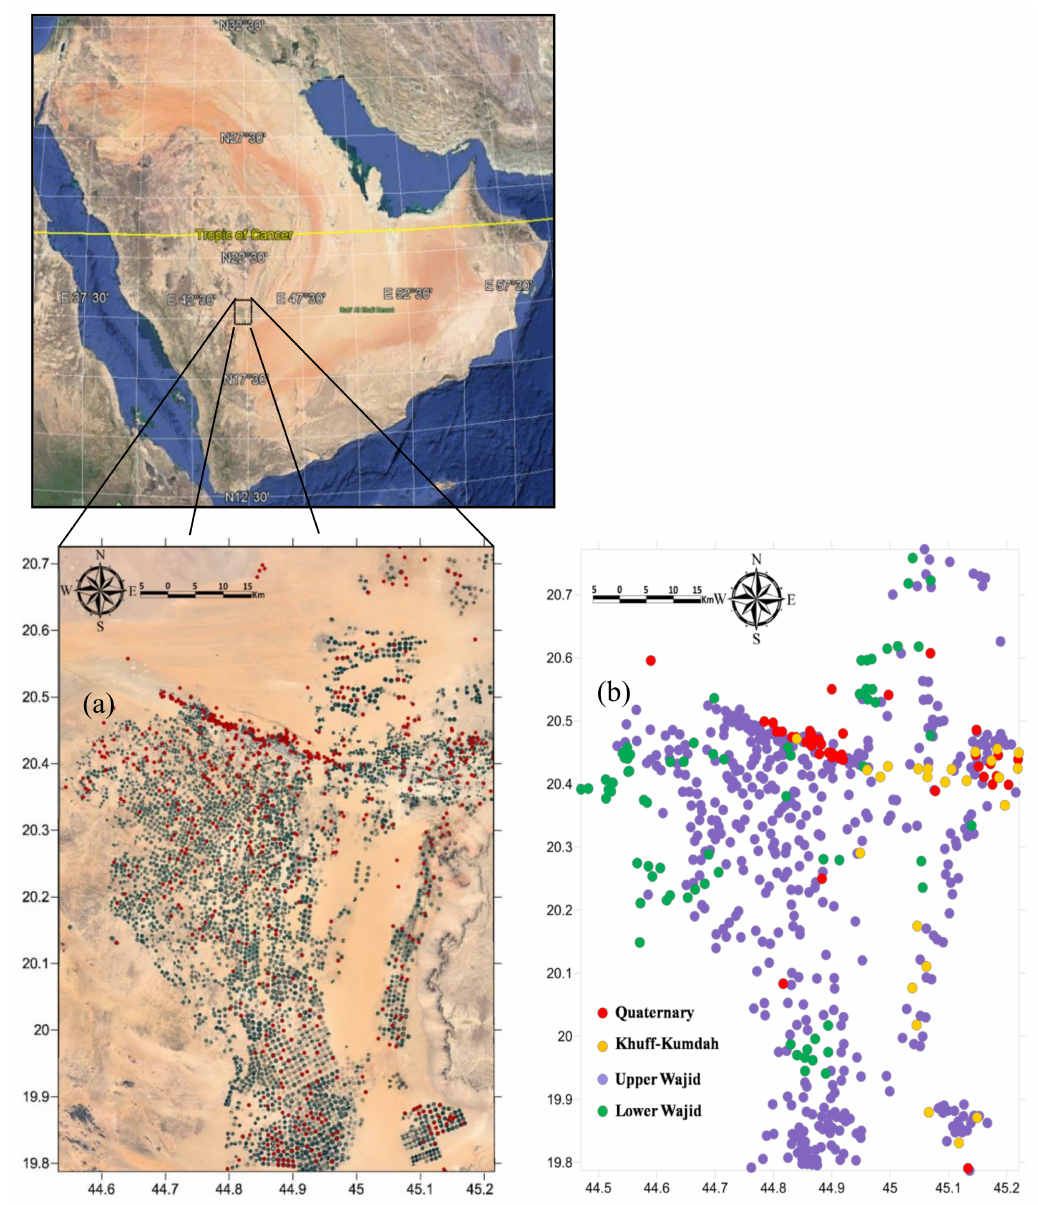
Figure 1. Location of sampled wells ( a ) red circles overlaying the Google earth image (December 2016), and ( b ) colored circles of the multi-layered Wajid